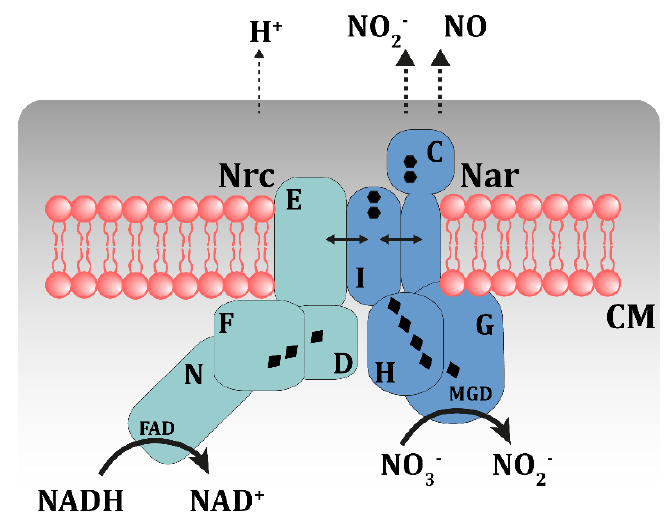
Figure 4. A putative nitrate respirasome in TthNAR1 . This scheme shows the likely structure of the nitrate respirasome, including the Nrc NADH dehydrogenase complex and the nitrate reductase. Activity of the complex will separate protons. Interactions detected by two-hybrids assays are indicated as double arrowheads lines. Heme groups are indicated as black hexagons and iron sulfur clusters as diamonds. The role of the NarC component of the NR as electron transporter towards NOR and NOS enzymes is indicated as discontinuous